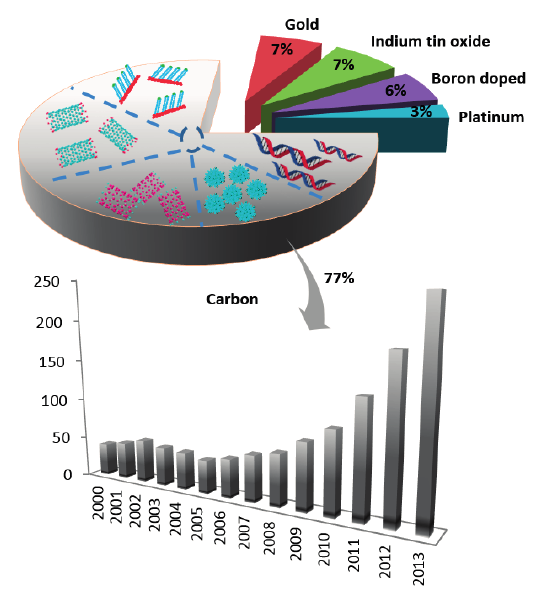
Figure 1. Papers published on electrochemistry of purine derivatives between 2004 and 2013 (from Web of Science